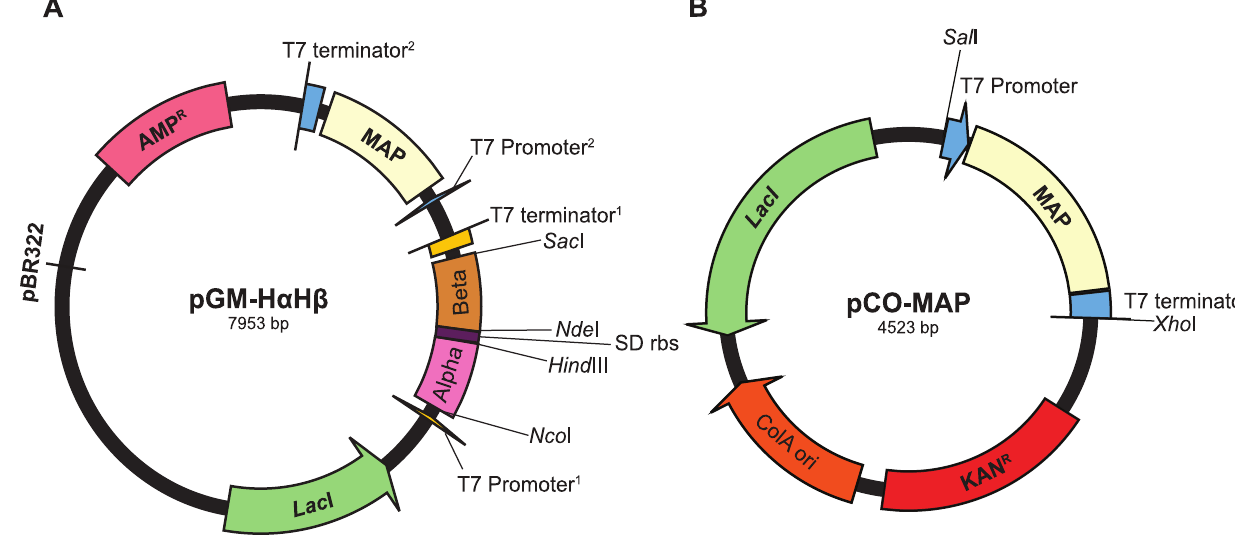
Figure 1. Design of the expression plasmids. As shown in Panel A, the pGM-H a H b plasmid system contains a cassette of tandemly arrayed a - and b -globin genes with a Shine-Dalgarno ribosomal binding site as a spacer DNA. The MAP cassette is located downstream of b -globin. As shown in panel B, the pCO-MAP plasmid contains a MAP cassette under the control of a T7 promoter along with a kanamycin resistance gene.